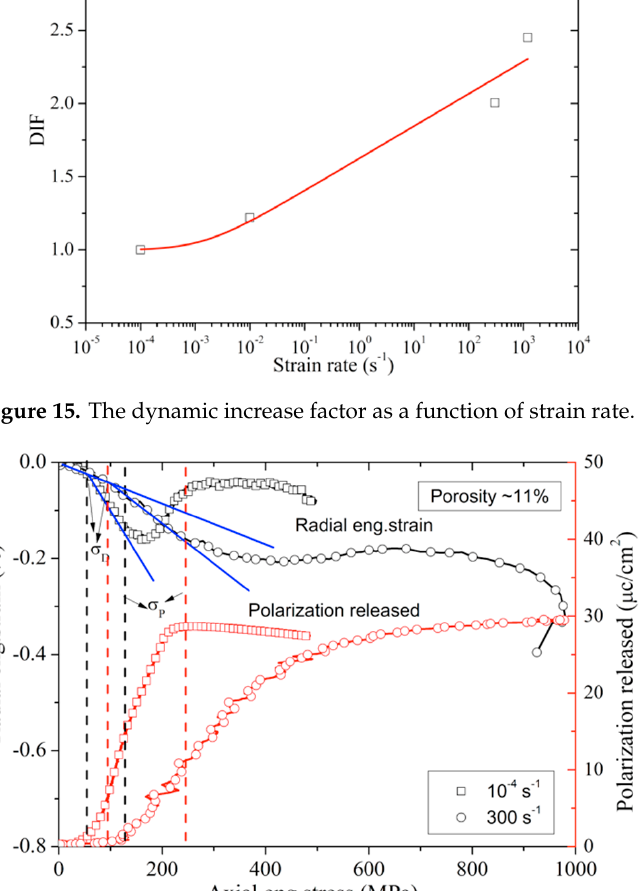
Figure 16. Eng.stress vs. radial eng.strain and eng.stress vs. polarization released curves of porous poled PZT95/5 ceramics at different strain rates.